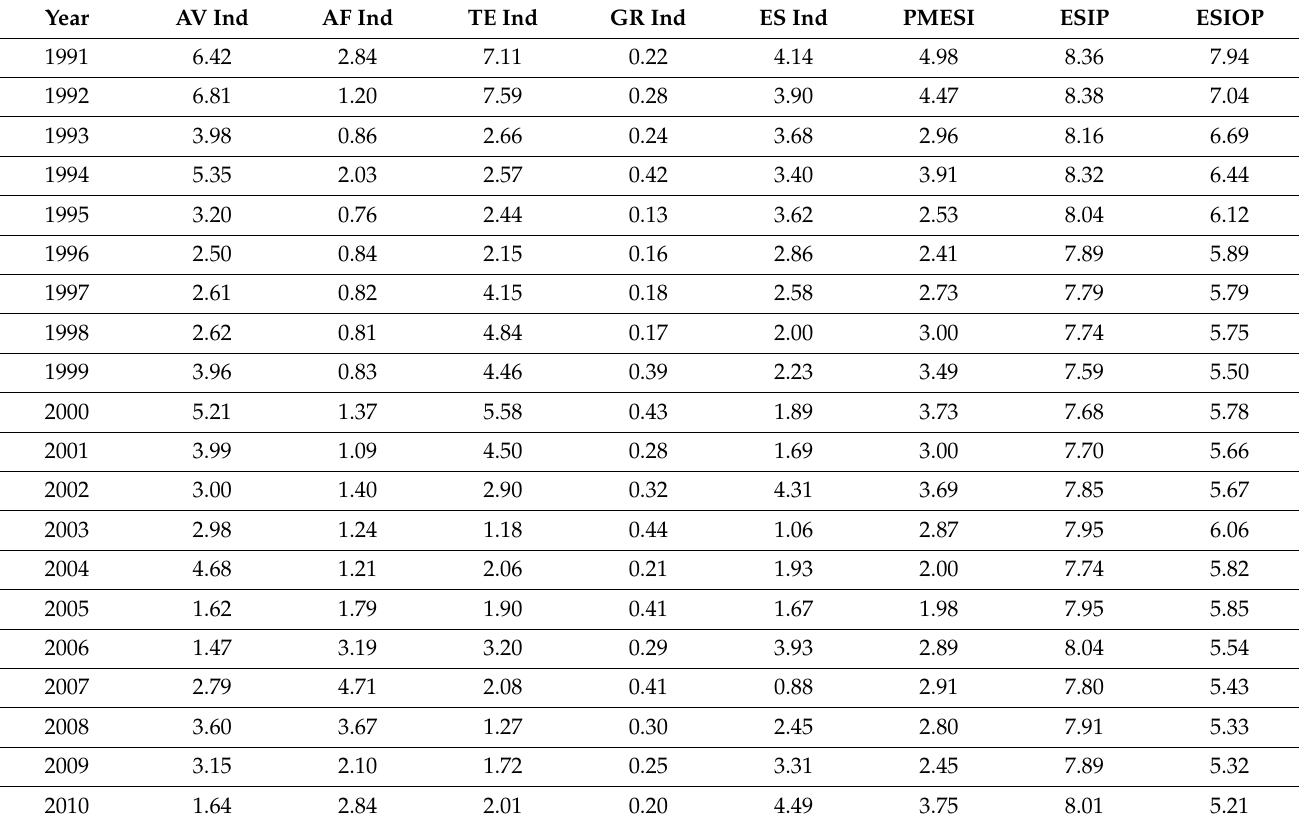
Table 5. Final scores of indices. Source: (Author’s